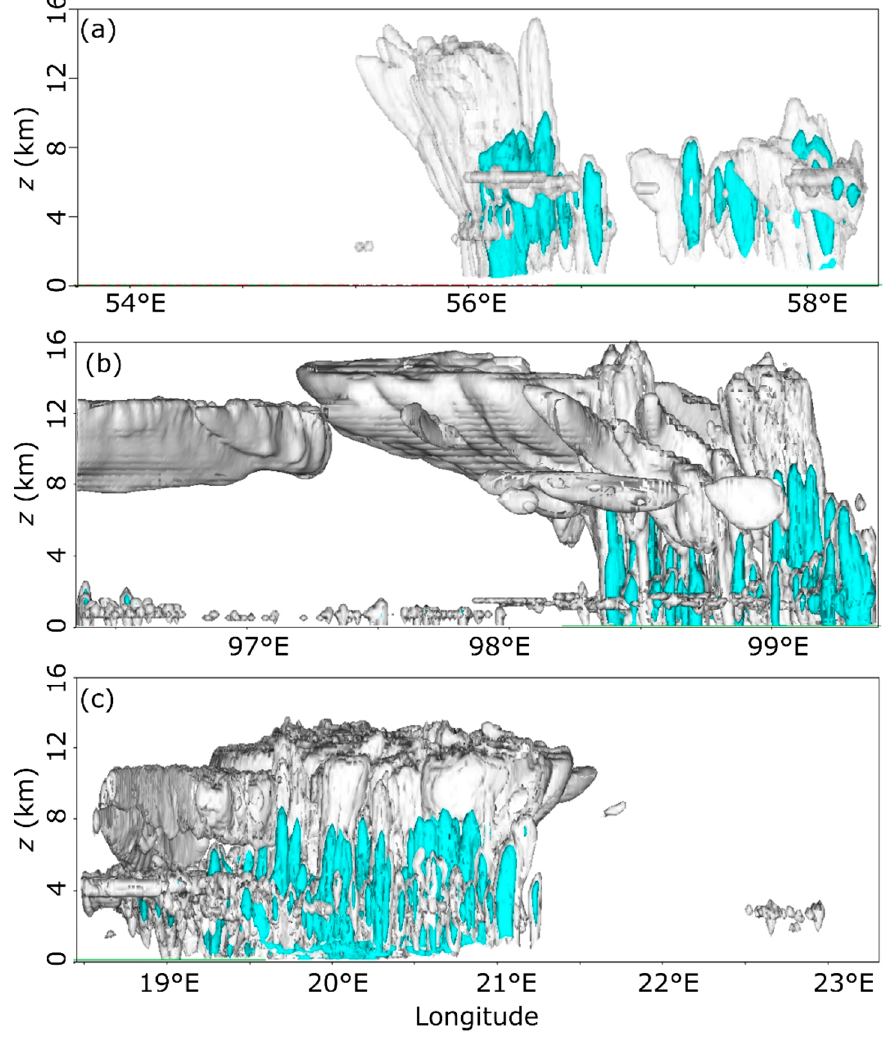
Figure 6. Side view (from the south) of the seeded cloud systems over ( a ) UAE; ( b ) Thailand; and ( c ) Serbia. See Figure 5 for interpretation of colors.